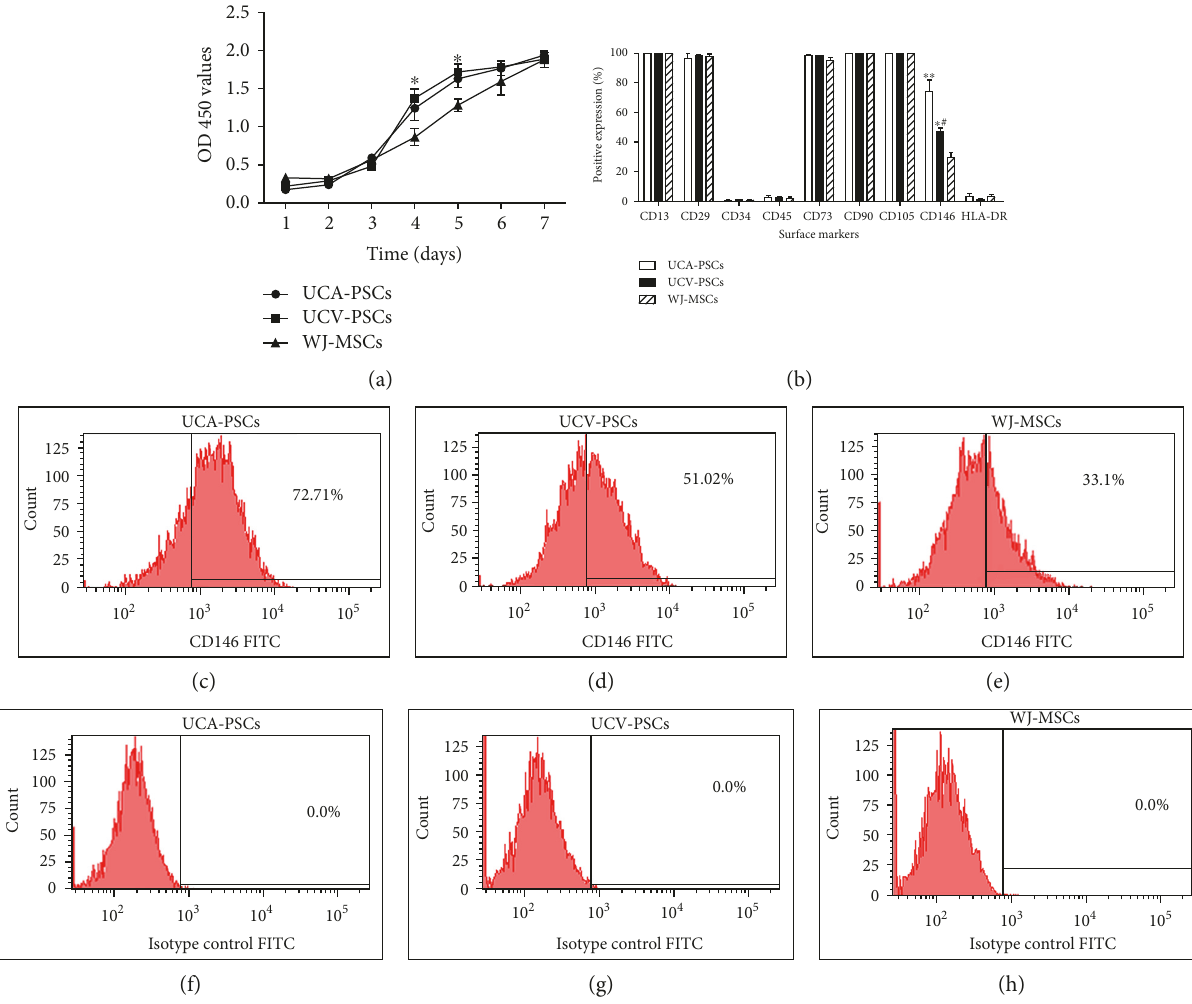
Figure 3: Proliferation and phenotype pro fi le of umbilical cord artery perivascular stem cells (UCA-PSCs), umbilical cord vein perivascular stem cells (UCV-PSCs), and Wharton ’ s jelly mesenchymal stem cells (WJ-MSCs). (a) Cell proliferation was continuously monitored for 7 days using cell-counting kit-8 (CCK-8), which showed that the number of UCA-PSCs was signi fi cantly higher than that of UCV-PSCs at days 4 and 5. However, the cell growth rate of UCA-PSCs, UCV-PSCs, and WJ-MSCs did not signi fi cantly di ff er. Bars represent the means ± SE of three independent experiments performed in triplicate. ∗ P < 0 05 , UCV-PSCs versus UCA-PSCs. (b) Pro fi les of cell surface epitopes in UCA-PSCs, UCV-PSCs, and WJ-MSCs. Abundance of cells positive for CD13, CD29, CD34, CD45, CD73, CD90, CD105, CD146, and HLA-DR, expressed as percentages, in UCA-PSCs, UCV-PSCs, and WJ-MSCs. Bars represent the means ± SE of donor samples ( n = 3 ). ∗∗ P < 0 01 , UCA-PSCs versus WJ-MSCs. ∗ P < 0 05 , UCV-PSCs versus WJ-MSCs. # P < 0 05 , UCV-PSCs versus UCA-PSCs. (c – h) Representative fl ow cytometric plots, including isotype control (IgG-FITC) (f –